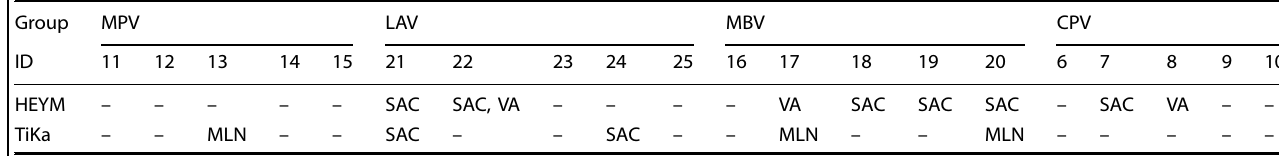
Table 2. Bacteriological results of oral vaccination groups. Group MPV